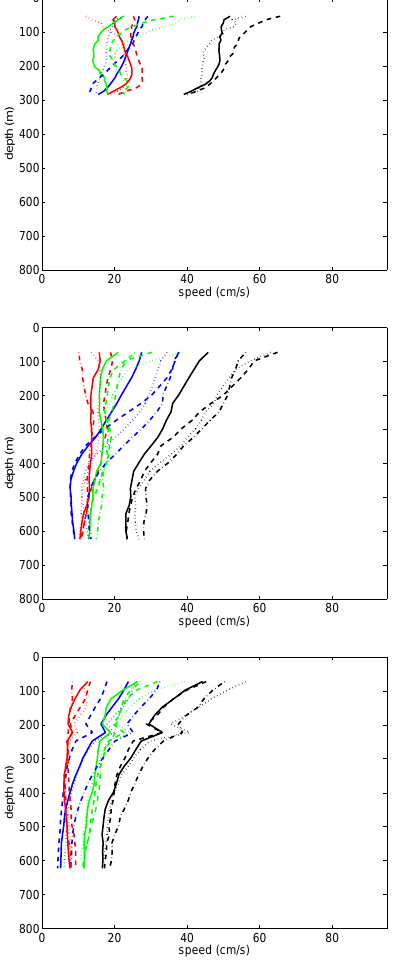
Fig. 5. Vertical profiles of 3 months averaged daily maximum speed for total currents (black), mean residual flow (blue), surge com- ponent (green) and tide (red) at locations NA, NB and NC from top to bottom. Continuous (–) line stands for average over June– September, dashed (- -) line stands for average over September- December, dotted (...) line stands for average over December– March and dash-dotted (-.-.) line stands for average over March– June.